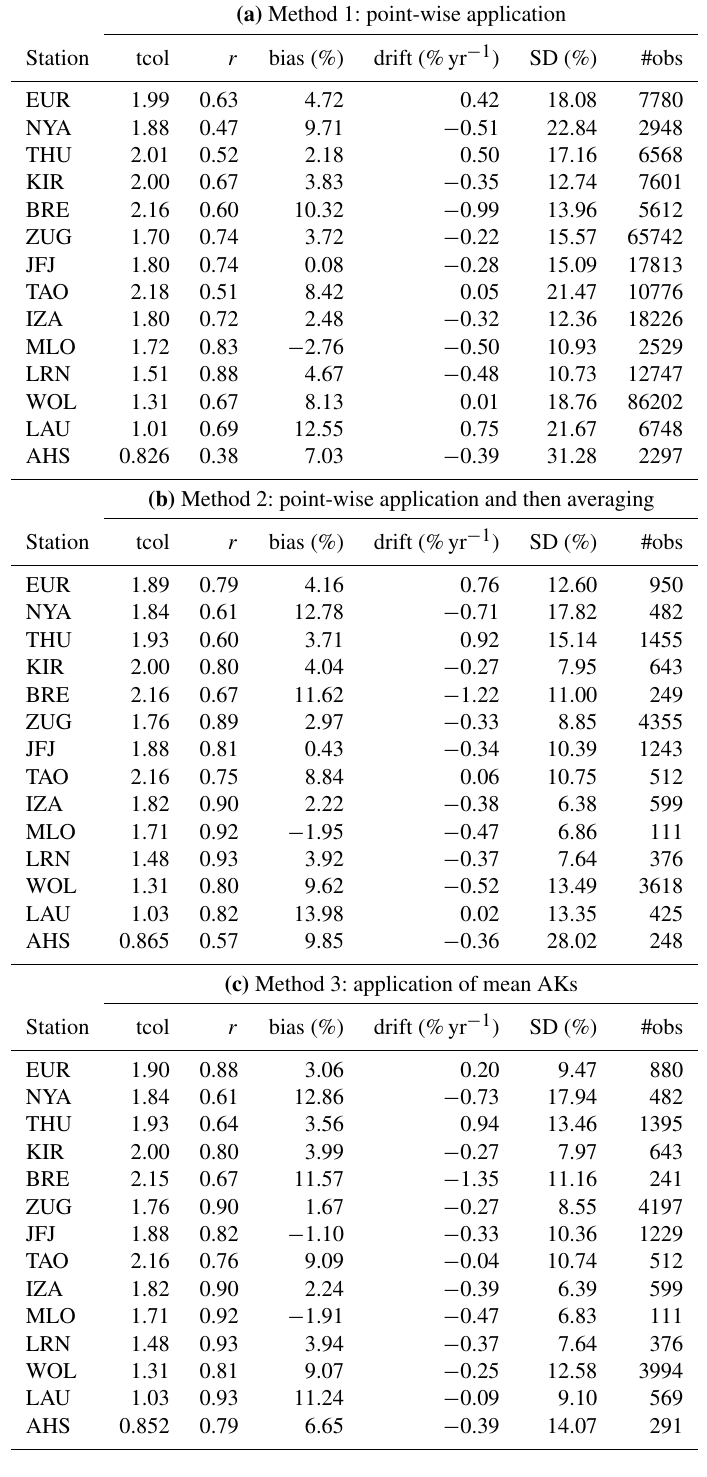
Table B1. Validation results and mean smooth FTS total column from the (a) point-wise method (Method 1), (b) point-wise followed by daily error-weighted averaging (Method 2), and (c) error-weighted mean AKs and a priori profiles (Method 3). Validation values in (c) are the same as reported in the main text, Table 3a, b, and c: they are reproduced here for clarity. Total column (tcol) is in × 10 18 moleccm − 2 .